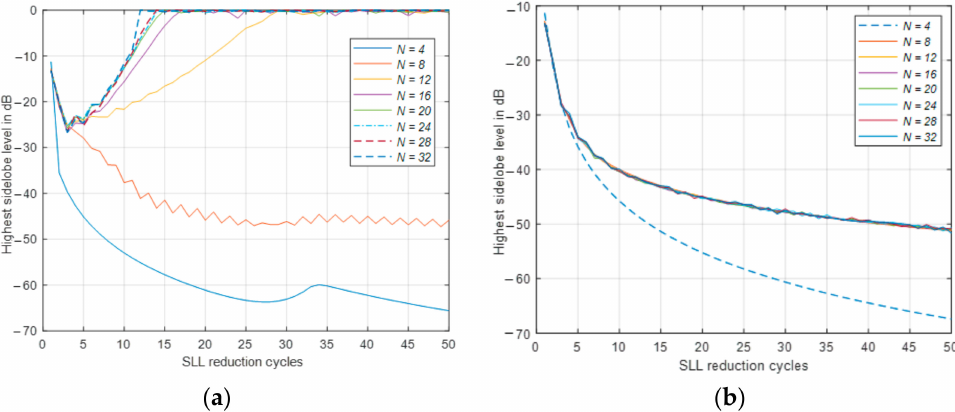
Figure 4. Convergence behavior of the SSR algorithms along with the number of reduction cycles at different array sizes and at: ( a ) δ = 1, ( b ) δ =